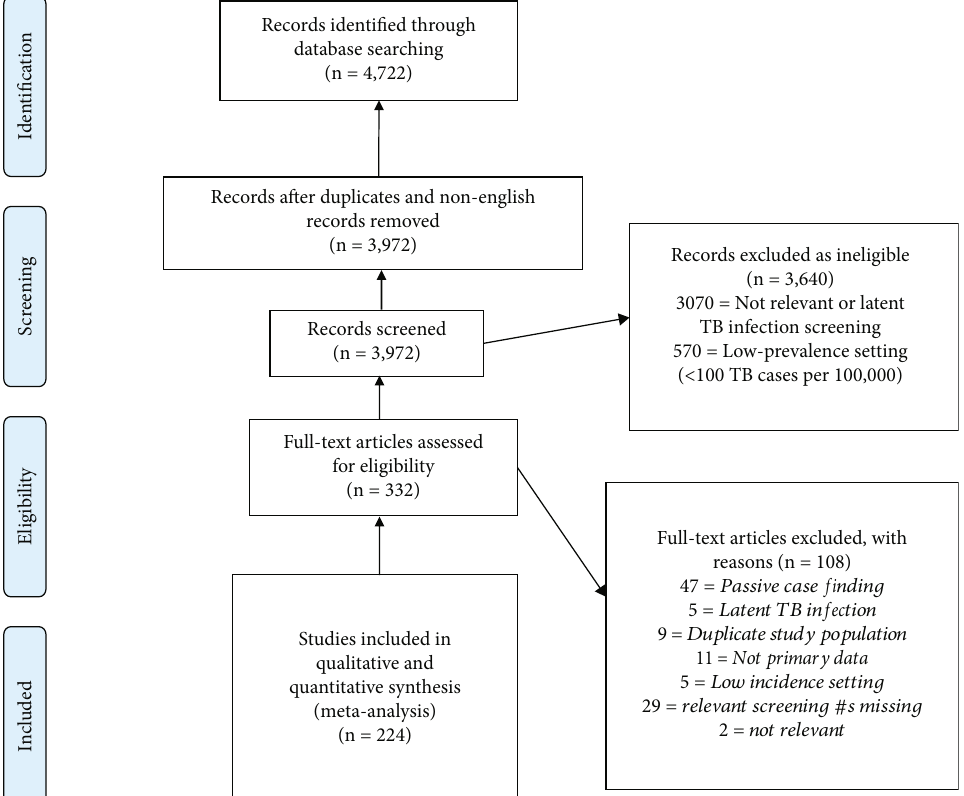
Figure 2: PRISMA